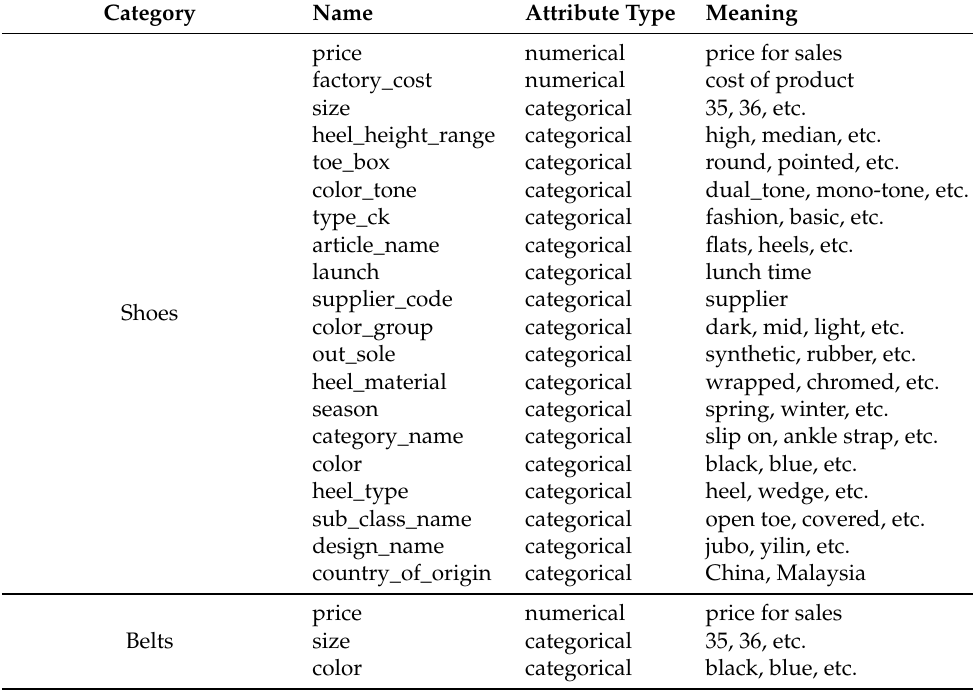
Table A2. Result of feature